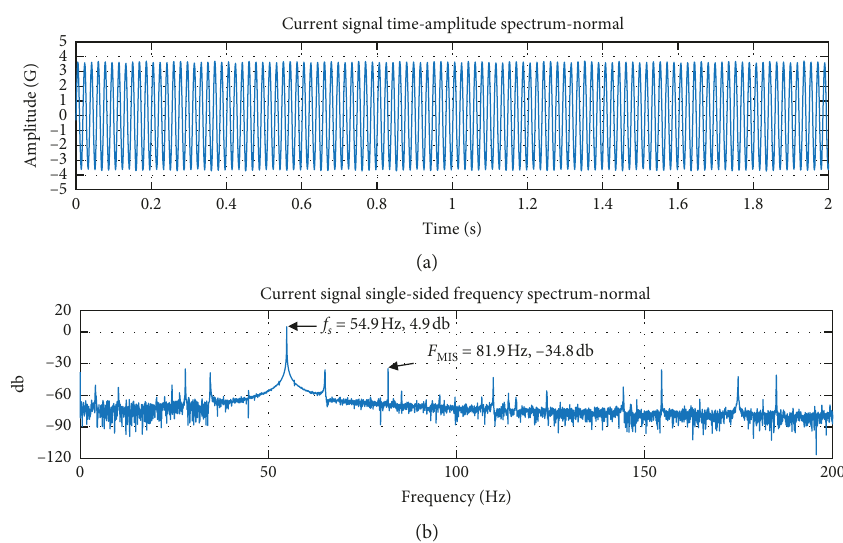
Figure 13: (a) Time response and (b) Fourier spectrum of the current signal under the normal condition. WPD coefficient of 55–57.5Hz